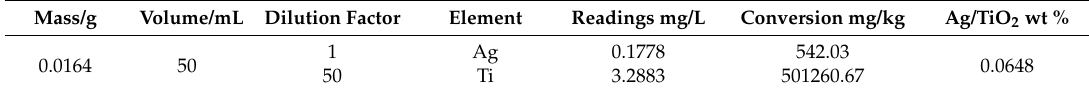
Table 1. ICP-AES date of Ag@TiO 2 .